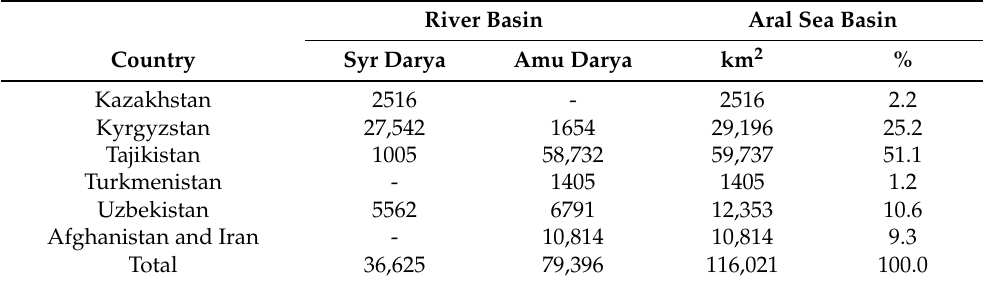
Table 1. Total natural river discharge in the Aral Sea basin (average annual discharge, km 3